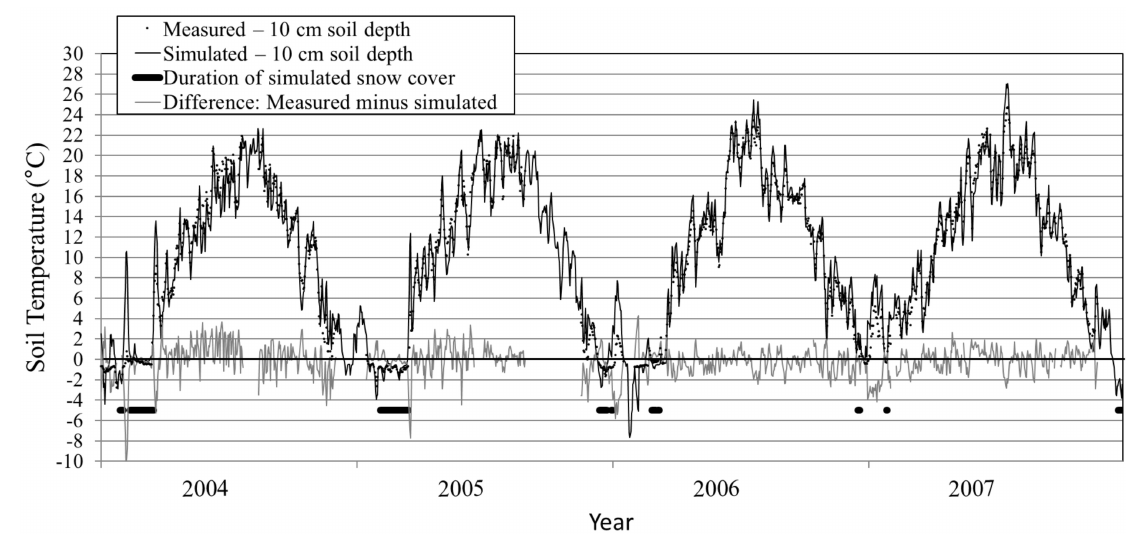
Figure 6. Measured and simulated daily mean soil temperatures at the 10-cm soil depth in Grafendorf (Austria) under a grassland three-cut regime from 2004 to 2007.